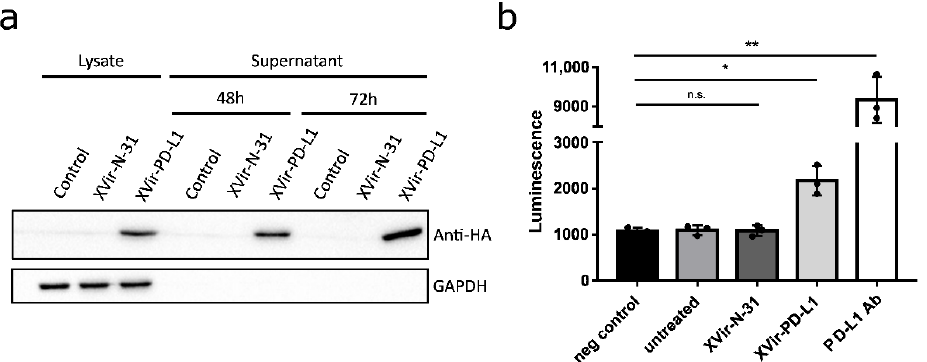
Figure 2. XVir-N-31-anti-PD-L1 expresses a functional PD-L1 antibody. ( a ) HEK293 cells were infected with 30 MOI of XVir-N-31 or XVir-N-31-anti-PD-L1, or were left untreated (control). Lysates or supernatants were collected at the indicated time points. The production and secretion of anti- PD-L1 were analyzed by immunoblot using an anti-HA antibody, GAPDH served as the loading control. ( b ) HEK293 cells were infected with 50 MOI of XVir-N-31, XVir-N-31-anti-PD-L1, or were left untreated. The supernatants were collected 48 h after infection and were subsequently used in an PD1/PD-L1 blocking assay. Increased luminescence indicates the PD-1/PD-L1 blockade. PBS served as the negative control, 10 μ g/mL anti-PD-L1 antibody for the positive control (XVir-PD-L1: XVir-N-31-anti-PD-L1; n = 3; SEM; n.s.: not significant; * p < 0.05, ** p < 0.01).